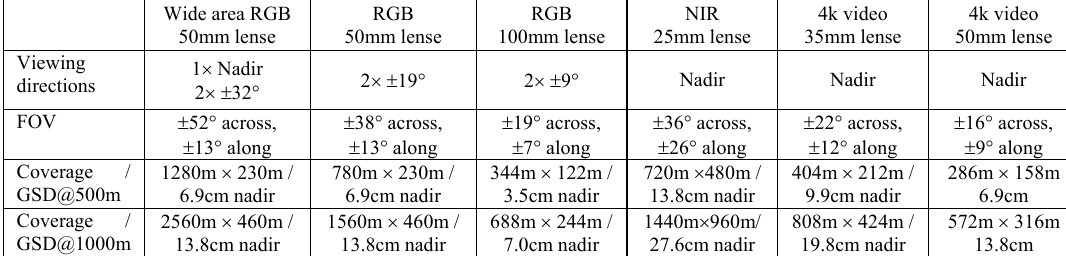
Table 3. Viewing geometry of six different sensor